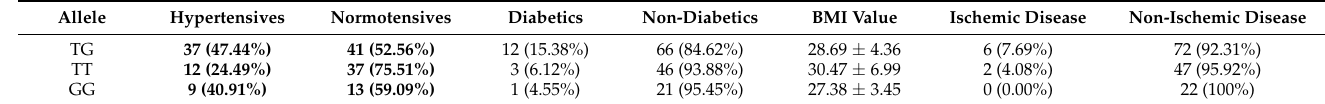
Table 4. The prevalence of arterial hypertension in the rs2736100 SNPs of the TERT gene. Statistically significant differences are indicated by boldface ( p < 0.05).